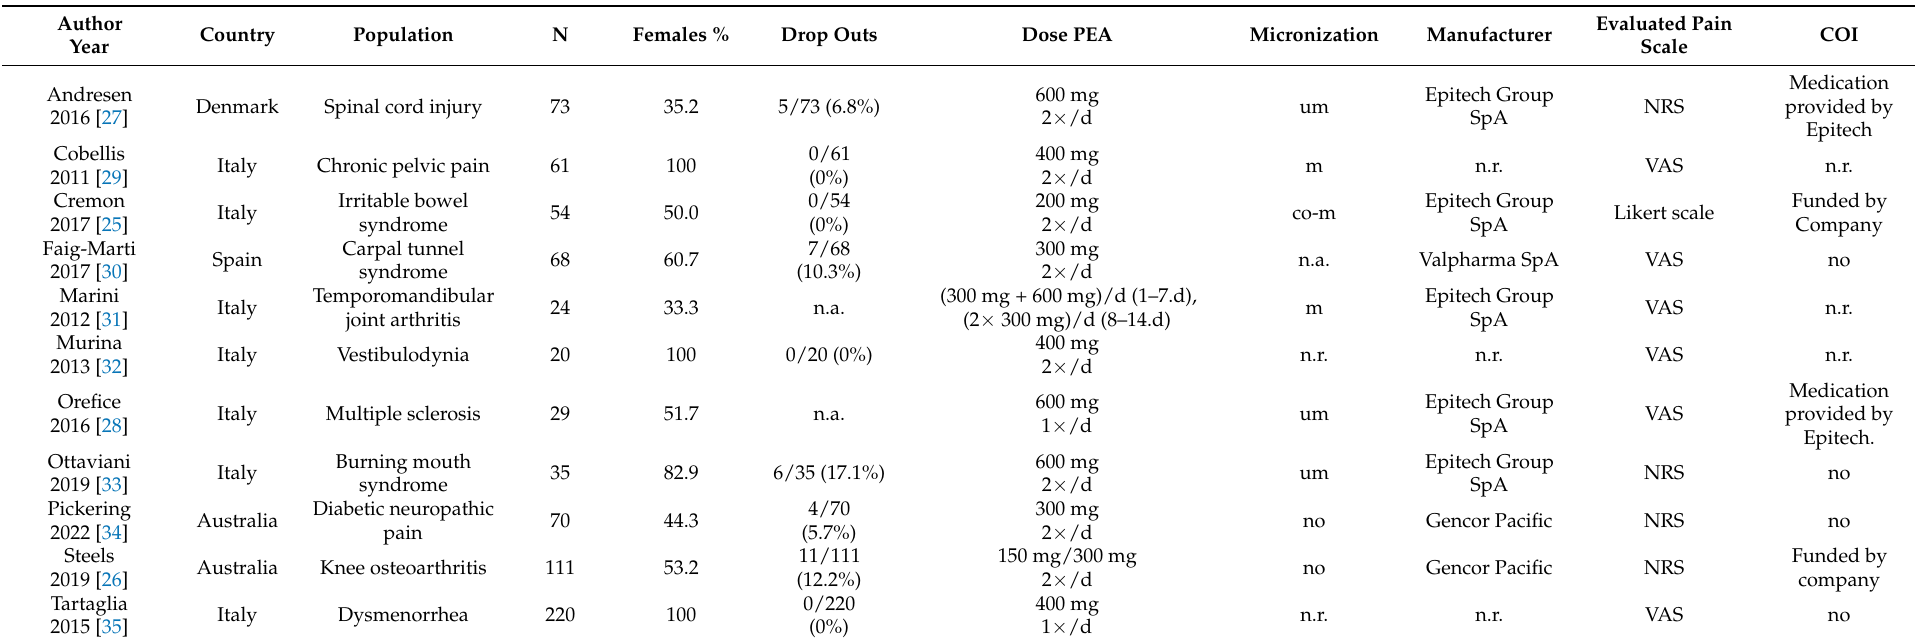
Table 3. Characteristics of included studies